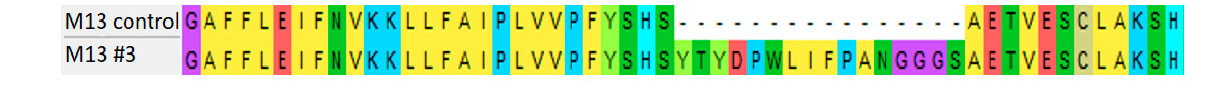
Figure 2. Alignment of the amino acid sequence containing the tumor-targeting peptide to the sequence of the coat protein of the M13 pIII phage containing no insert.